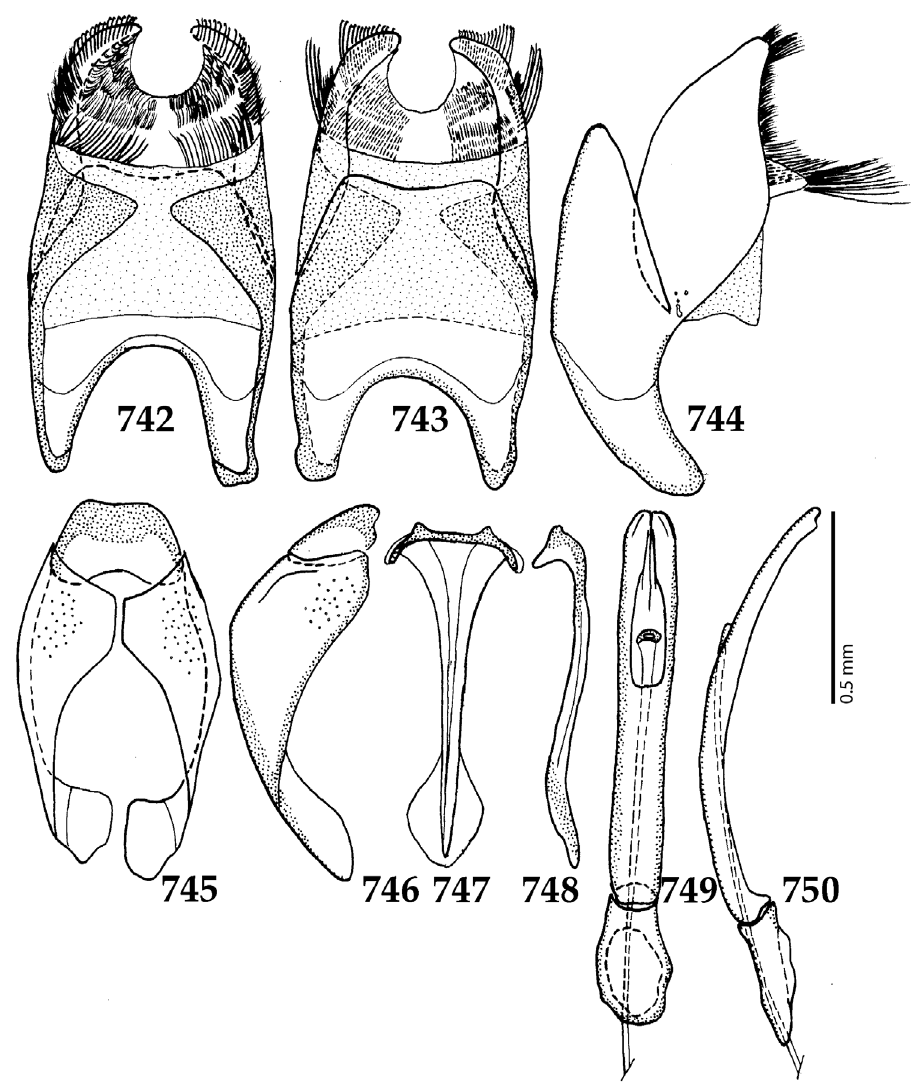
Figures 742–750. 742 Tomogenius ripicola (Marseul, 1870) male terminalia: 8 th sternite + 8 th tergite, ventral view 743 ditto, dorsal view 744 ditto, lateral view 745 male terminalia: 9 th + 10 th tergites, dorsal view 746 ditto, lateral view 747 male terminalia: spiculum gastrale, ventral view 748 ditto, lateral view 749 male terminalia: aedeagus, dorsal view 750 ditto, lateral view. Mandibles (Fig. 732) punctate, with rounded outer margin, acutely pointed, sub- apical tooth on inner margin of left mandible obtuse; labrum even, convex, punctate, approximately twice as wide as long, labral pits each with single long labral seta; ter- minal labial palpomere elongated, its width about one-fourth its length, pointed api- cally; mentum sub-trapezoid, anterior angles slightly produced, anterior margin